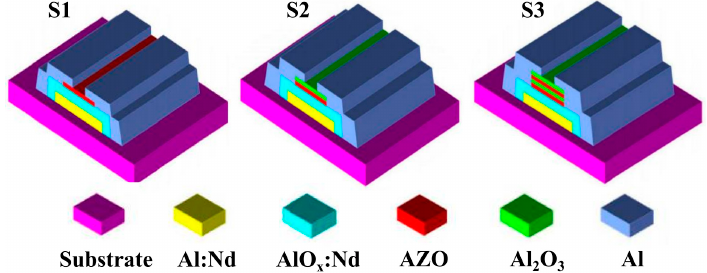
Figure 1. Schematic cross-sectional images of Devices S1, S2, and S3 with different types of channel layer structures. layer